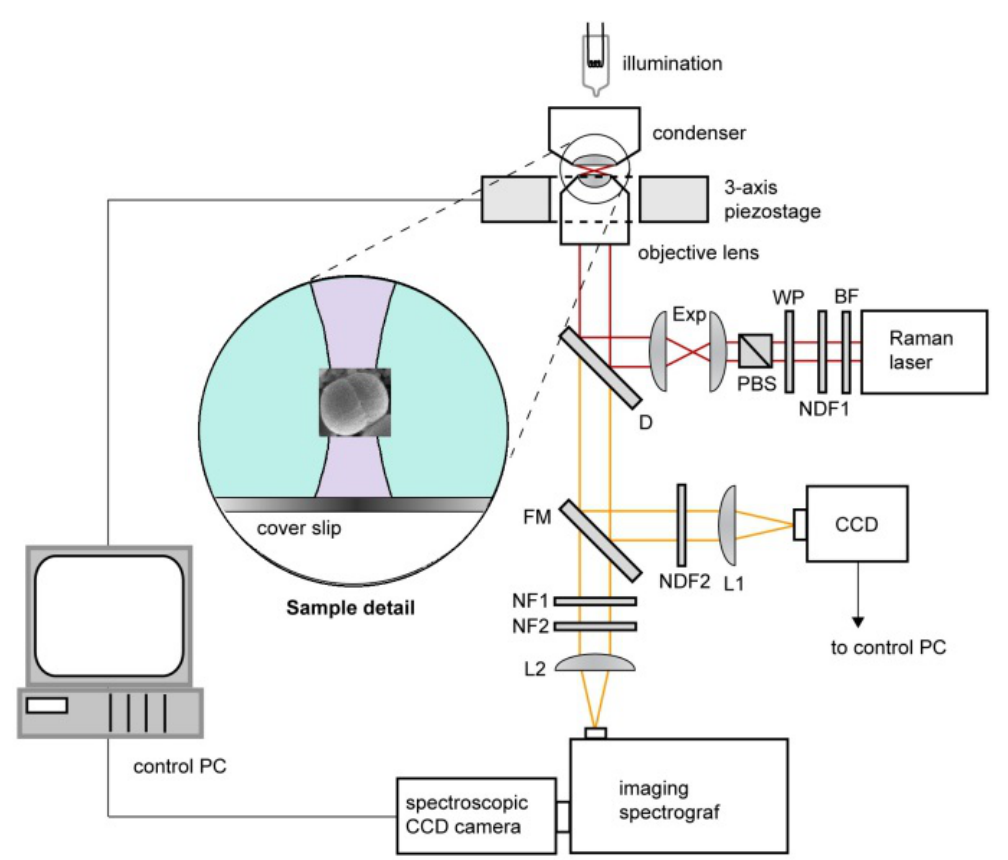
Figure 5. Schematic diagram of the Raman tweezers setup where the same laser beam is used for optical trapping and Raman scattering. BF–band pass filter, D–dichroic mirror, Exp–beam expander, FM–flipping mirror, L1,2–lenses, NDF1,2–neutral density filters, NF1,2–notch filters, PBS–polarizing beam splitter, WP–lambda-half wave plate. Inset shows the detail of optically trapped bacterium near the focus the laser beam at the wavelength 785